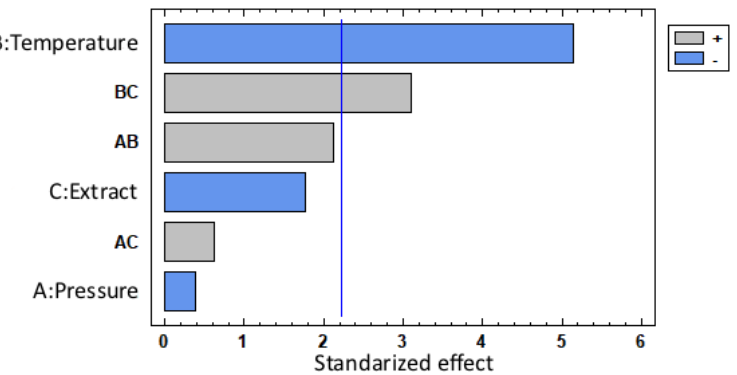
Figure 9. Pareto chart showing AOC values of the MLE-impregnated PLA